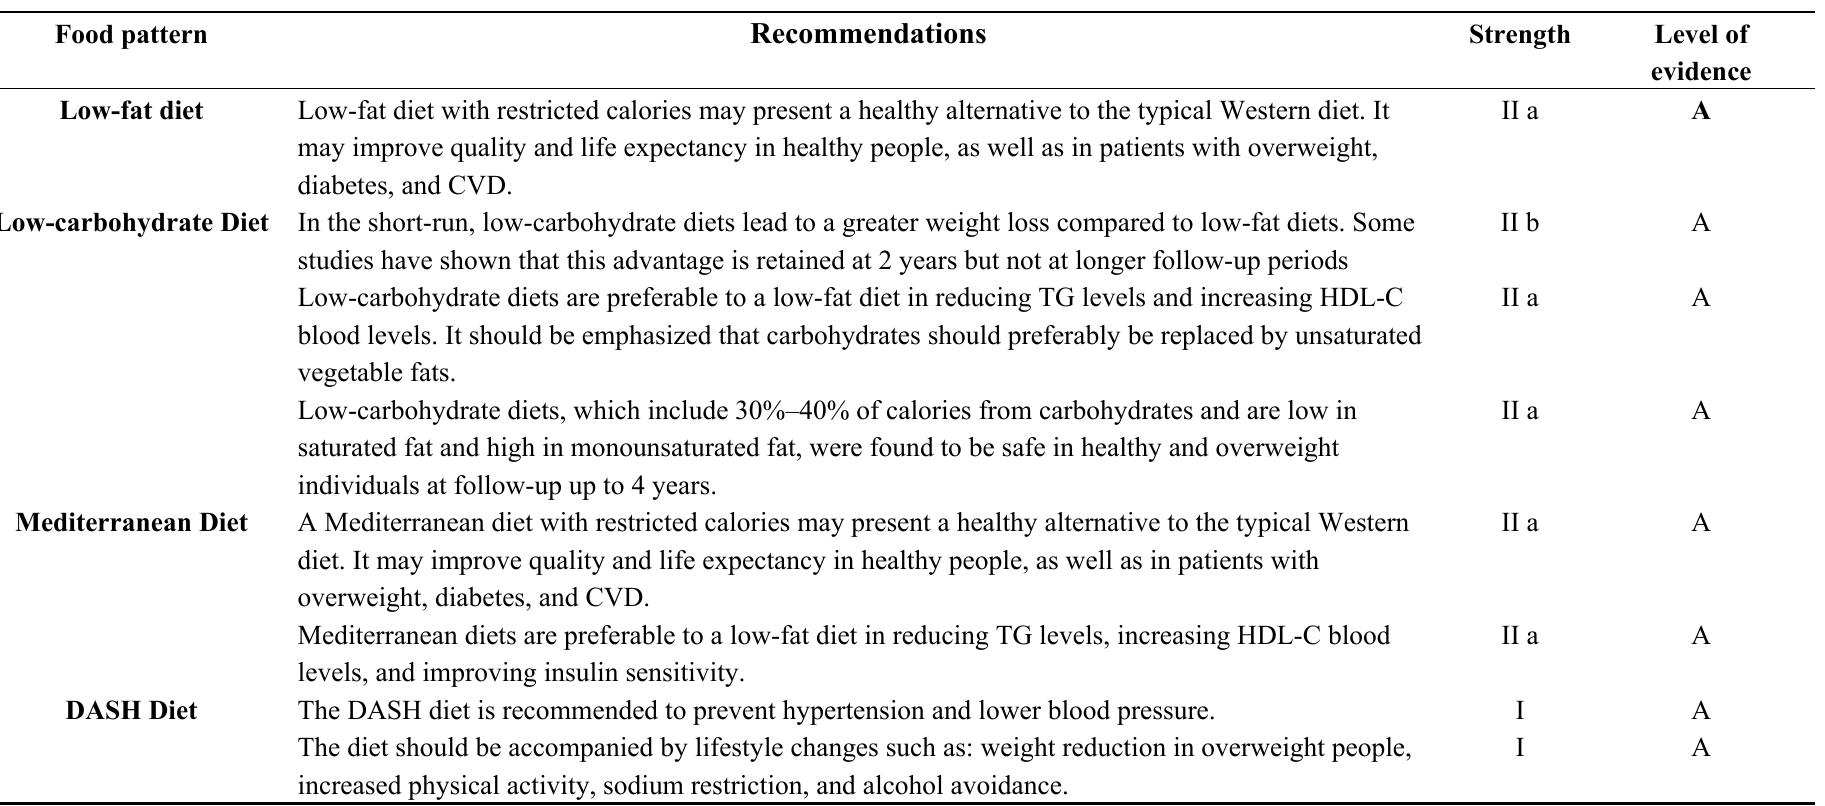
Table 4. Level of evidence and classes of recommendations for food